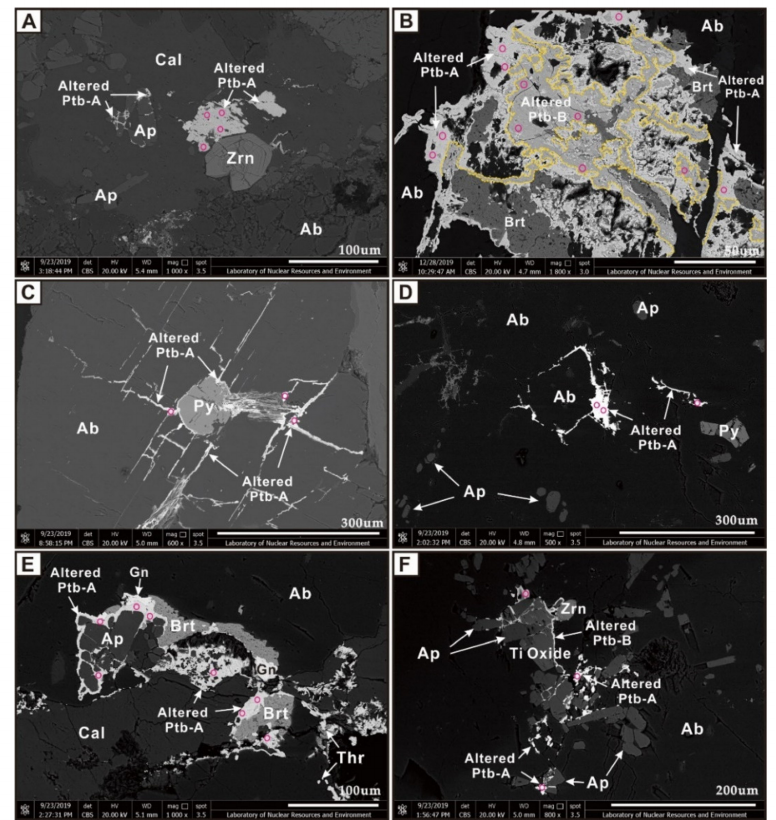
Figure 5. Backscattered electron (BSE) images of altered pitchblende A and altered pitchblende B in the Jiling uranium deposit. ( A ) Altered pitchblende A disseminated in calcite, adjacent to zircon and infilling microfractures within apatite crystal. ( B ) Large altered pitchblende (consisting of altered pitchblende A and B) disseminated in the albite crystals and cemented in the barite. ( C ) Altered pitchblende A infilling microfractures within albite crystal, and rimming a pyrite crystal. ( D ) Altered pitchblende A rimming an albite crystal and along microfractures, apatite and pyrite crystals are nearby. ( E ) Altered pitchblende A as a rim around barite, apatite and calcite crystal coexisting with galena and thorite. ( F ) Altered pitchblende A and B rims around apatite and titanium oxide in albite. Ab—albite; Ap—apatite; Brt—barite; Cal—calcite; Gn—galena; Thr—thorite; Ptb—pitchblende; Py—pyrite; Ti Oxide—titanium oxide; Zrn—zircon. Red circles indicate the location of EMPA